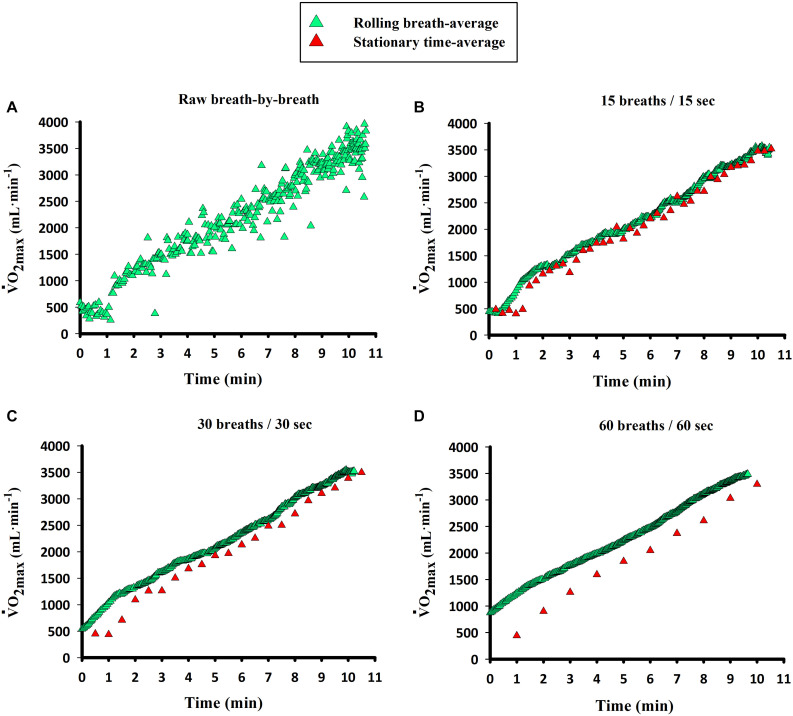
Representative V.O2 data during an incremental exercise to exhaustion in one demonstrative subject using different averaging blocks (breaths and seconds). Calculation of averaging blocks for the breath-based strategy refers to a “rolling” breath average, while time-based data were stationary time-averaged, both with the corresponding length of the block (e.g., 10 breaths or 10 s). Data are presented as (A) raw breath-by-breath, (B) 15 breaths and 15 s, (C) 30 breaths and 30 s, (D) 60 breaths and 60 s. Note the slightly higher values of breath-based averages compared to time-based averages of the same number, although a high concordance (concordance correlation coefficient = CCC > 0.97) is present. Modified from Martin-Rincon et al. (2019) with kind permission.